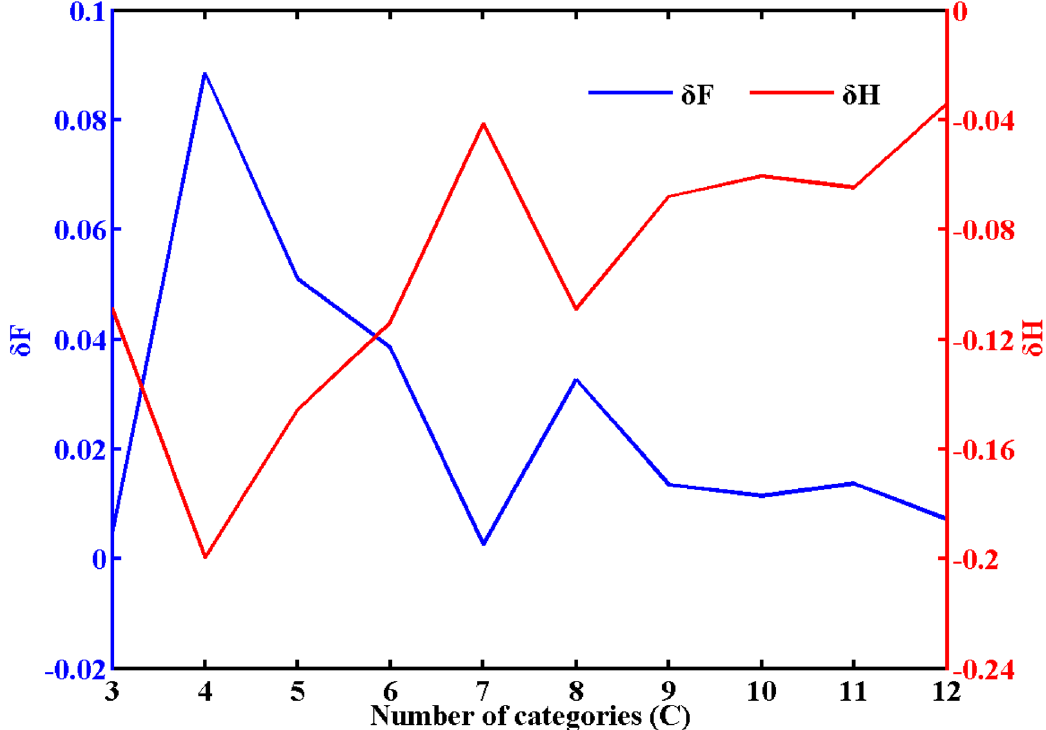
Figure 7. When m = 2.0, the entropy and distribution coefficient change with the number of categories ( C ).